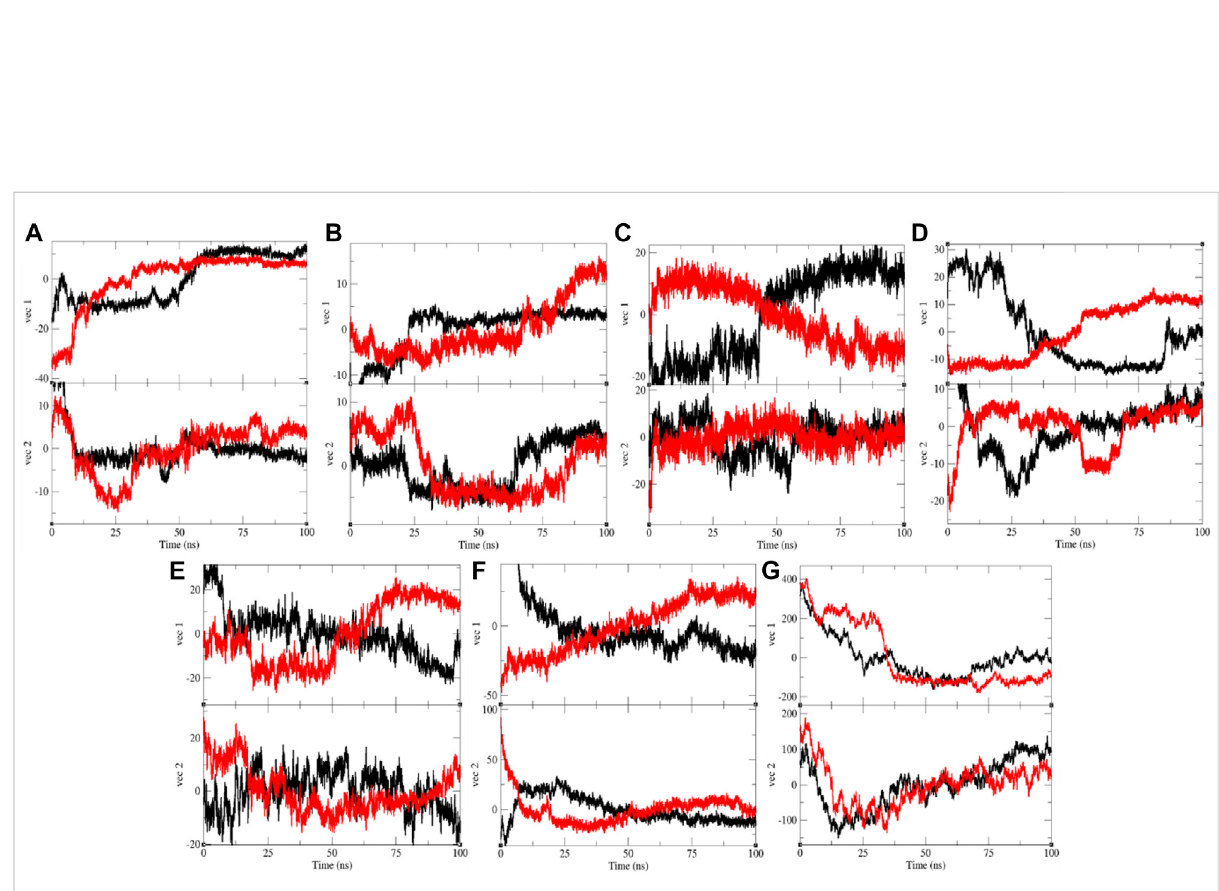
FIGURE 10 Projection of eigenvectors and components. The projections of trajectories on eigenvectors for (A) CTD (black) and CTD-remdesivir (red), (B) Eprotein (black) and Eprotein-remdesivir (red), (C) Mprotease (black) and Mprotease-remdesivir (red), (D) Mprotein (black) and Mprotein-remdesivir (red), (E) NTD (black) and NTD-remdesivir (red), (F) RDRP (black) and RDRP-remdesivir (red), and (G) Sprotein (black), and Sprotein-remdesivir (red),